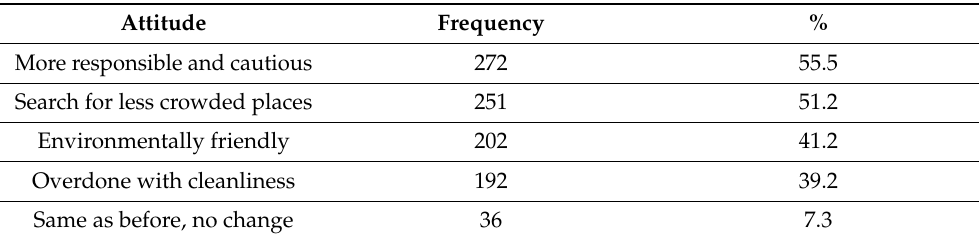
Table 3. Attitude to travel to a